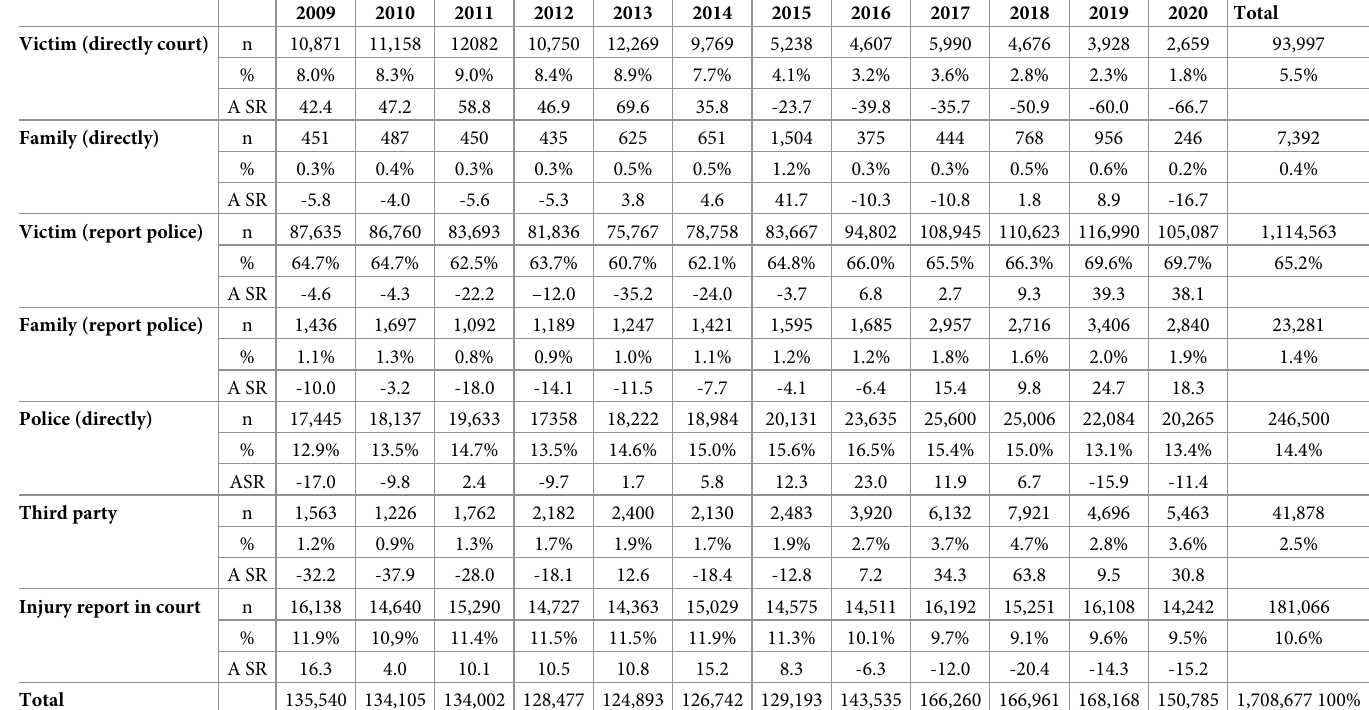
Table 5. IPVAW reports filed according to